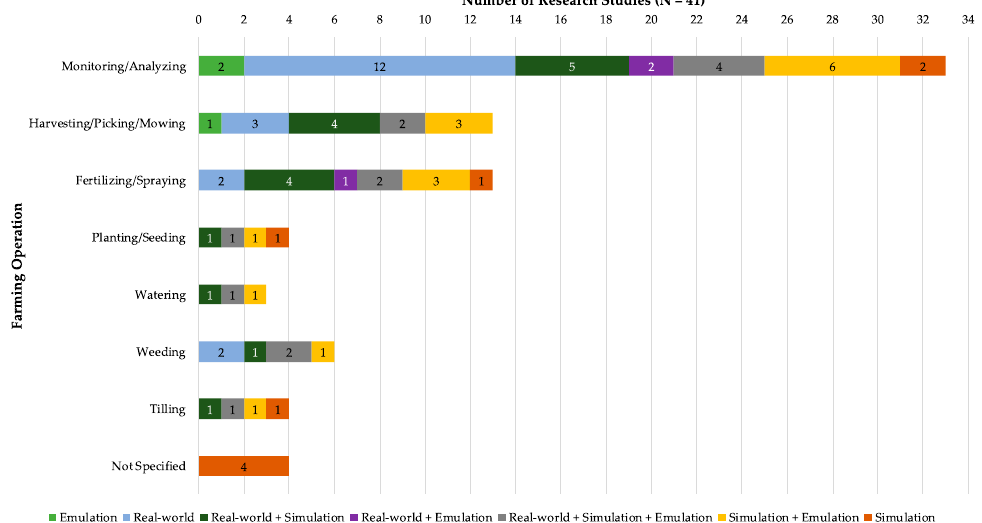
Figure 2. Distribution of the reviewed publications based on the elaborated research analysis approach per farming operation.